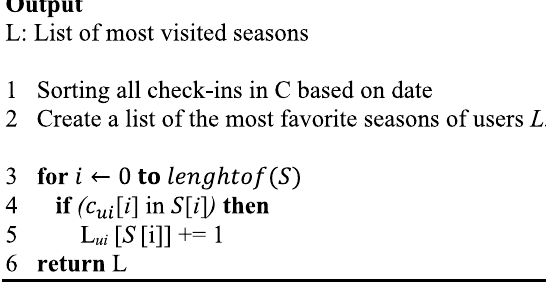
Algorithm 1. Extracting favorite season(s) of each user Algorithm 1 tries to extract a list of seasons that the